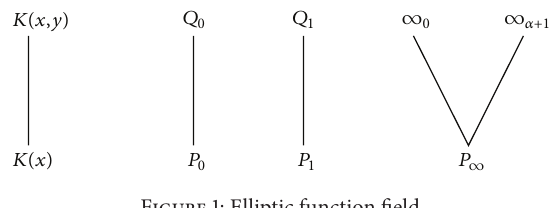
Figure 1: Elliptic function